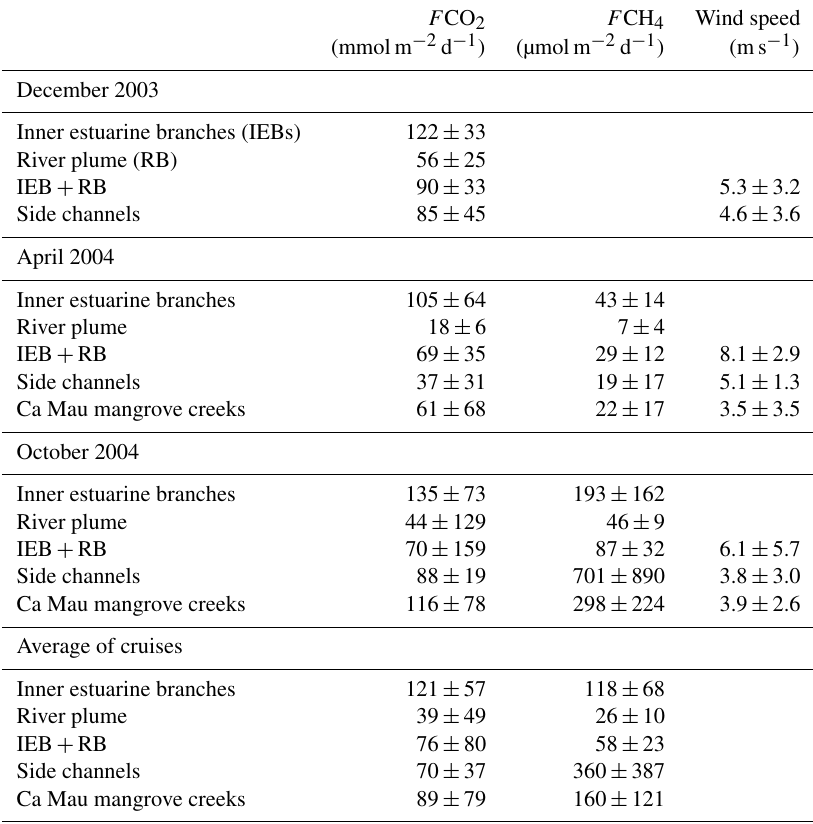
Table 1. Average ± standard deviation in air–water fluxes of CO 2 ( F CO 2 , mmolm − 2 d − 1 ) and CH 4 ( F CH 4 , µmolm − 2 d − 1 ) , and wind speed (ms − 1 ) in December 2003, April 2004, and October 2004 in the three inner estuarine branches of the Mekong delta (M e y Tho, Hàm Luông, and C ´ˆ o Chiên), respective river plume and side channels, and in the Ca Mau province mangrove creeks. F CO 2 F CH 4 Wind